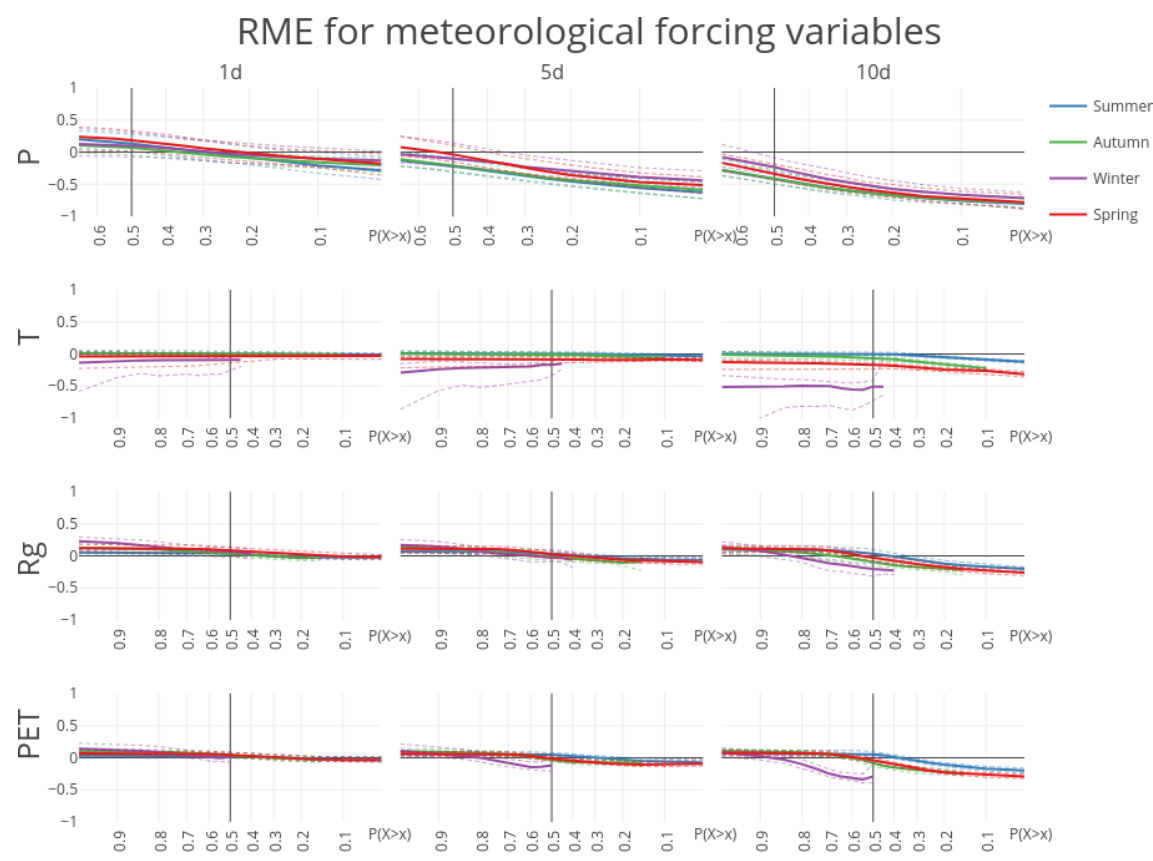
Figure 6. Relative mean error (RME) for the four forcing variables for the 148 HBV subbasins for the whole year. RME is aggregated into mean (solid), 10th and 90th percentiles (dashed). Note that the CRPSS at P(X ≥ x) = 0 . 1 or 0.7 is calculated over, respectively, the 10% and 70% highest observation–forecast pairs, conditioned on the